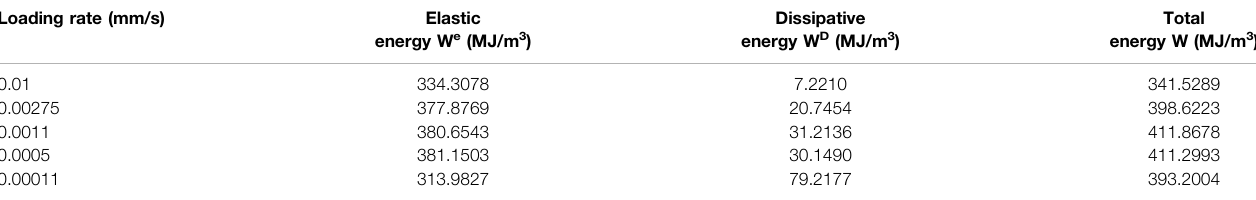
TABLE 4 | Energy values of samples under peak strength at different loading rates.